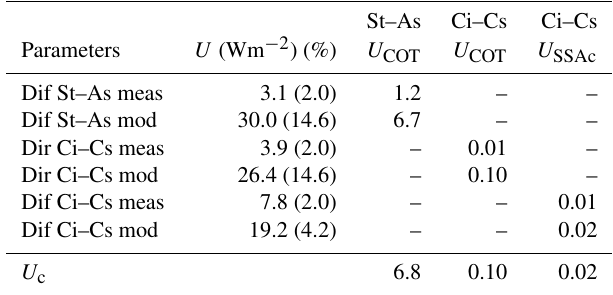
Table 3. Uncertainty analysis for estimated COT DSR values